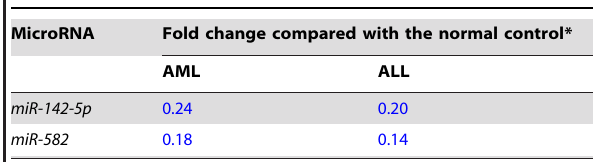
Table 3. Differentially expressed microRNAs in pediatric AML and ALL compared with the normal